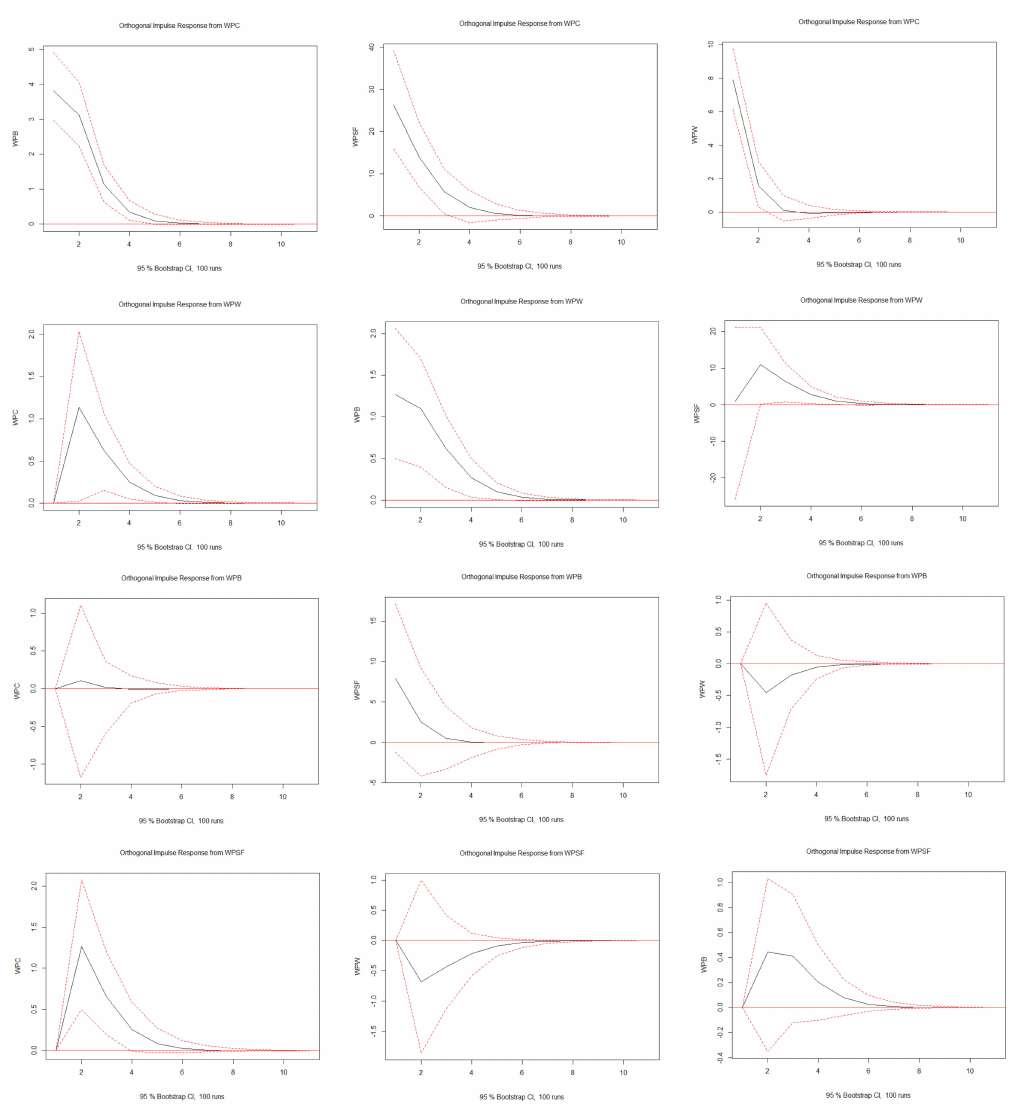
Figure 2. VAR (1) IRF with twelve combinations of variables in the system. Note: Plots indicate the VAR (1) impulse response function with twelve combinations of WPC, WPB, WPW and WPSF. IRF results stand within a 95% confidence interval (CI) and are constrained to ten periods ahead. Red lines represent error margins, and simulations were performed with 100 trials. Because our differenced series are monthly, the IRF effects were measured for the next ten months. The variables display the period from 1